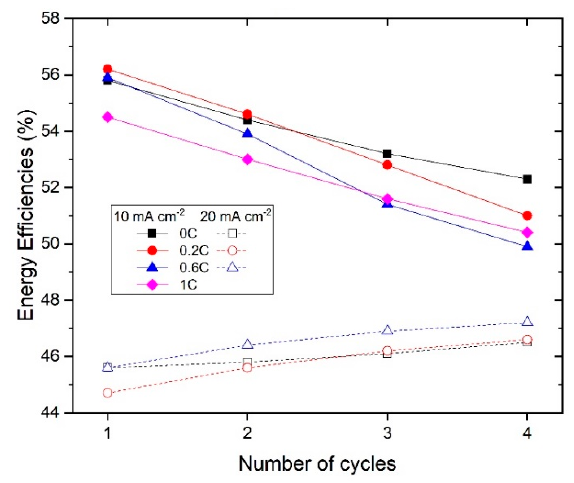
ffi ciency of the di ff erent Figure 7. Energy efficiency of the different slurries. Figure 7. Energy efficiency of the different slurries. Figure 7. Energy e